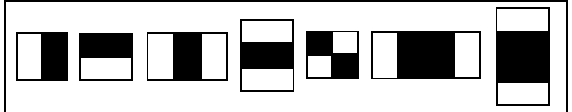
Fig. 1 Haar feature sets used for weak feature learning Fig. 1. The seven basic Haar feature types used for training.